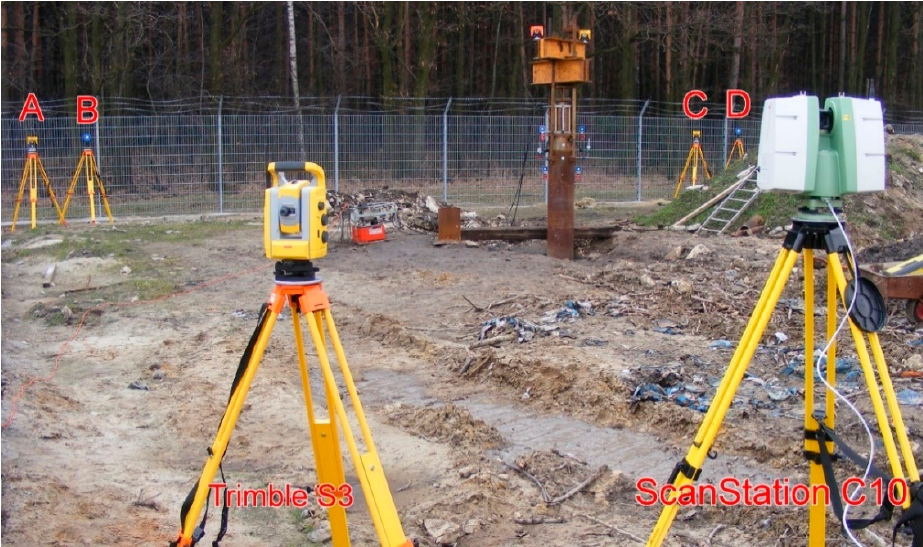
Figure 7. The geodetic instruments (total station Trimble S3 and laser scanner Leica ScanStation C10) with some reference points and self-balanced testing appliance.